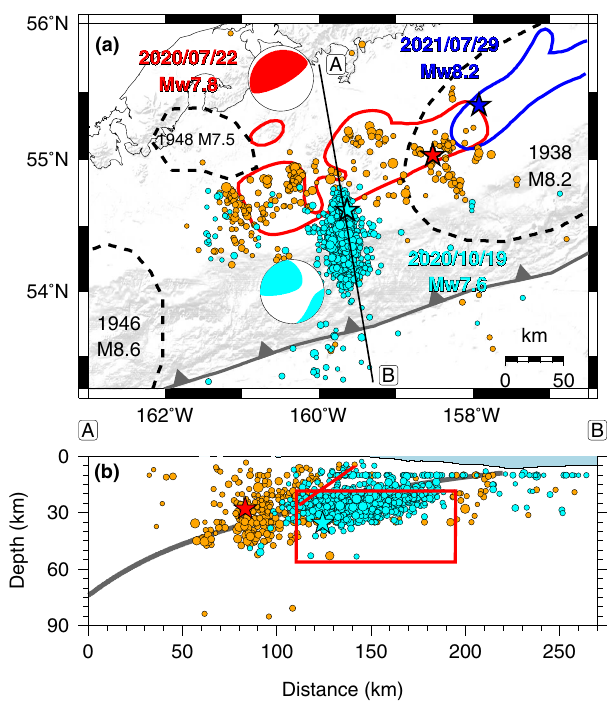
Fig.1|Regionalsettingforthe19October2020earthquake.a Mapofthe22July 2020 M W 7.8 Simeonof megathrust event epicenter (red star), aftershocks prior to 19 October 2020 (gold circles with radii scaled by magnitude), fi nite-slip (>0.5m) region 6 (red contours), and long-period moment tensor (red); the 19 October 2020 M W 7.6 aftershock epicenter (cyan star), aftershocks (cyan circles with radii scaledbymagnitude),andlong-periodmomenttensorfromtheUSGS-NEIC(cyan); the 29 July 2021 M W 8.2Chignikmegathrust event fi nite-slip region (>0.5m) 16 (blue contour) and epicenter (blue star); and nearby large historic event rupture zones (blackdashedlines).LineABindicatesthepositionofthecross-sectionin( b ),which shows the depth distribution of the aftershock sequences, position of the slab interface 9 (bold line), and projections of the two-faults in the fast-slip rupture model in Fig. 3 (red